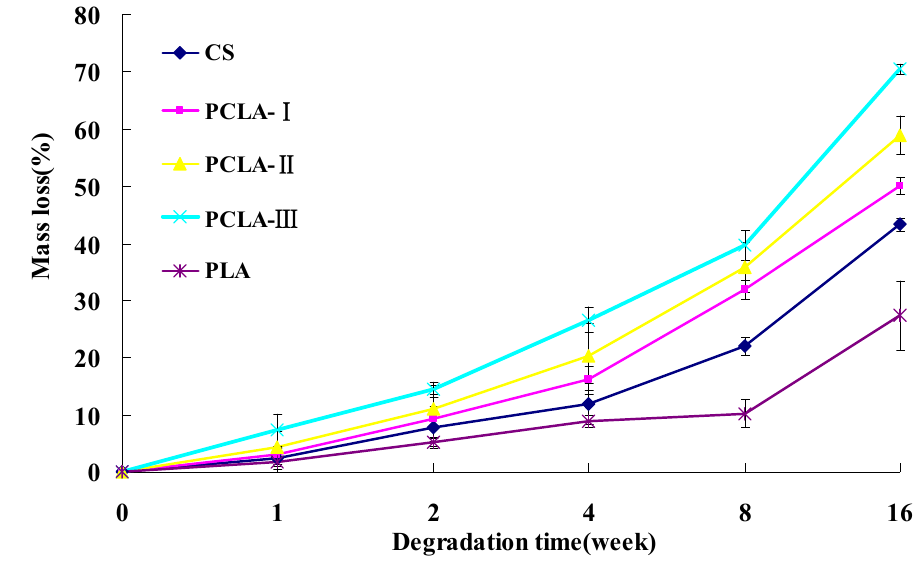
Figure 3. Degradation of PCLA materials by lysozyme (4 mg/mL) at pH = 7.4 and 37 °C (mean ± SD, n =